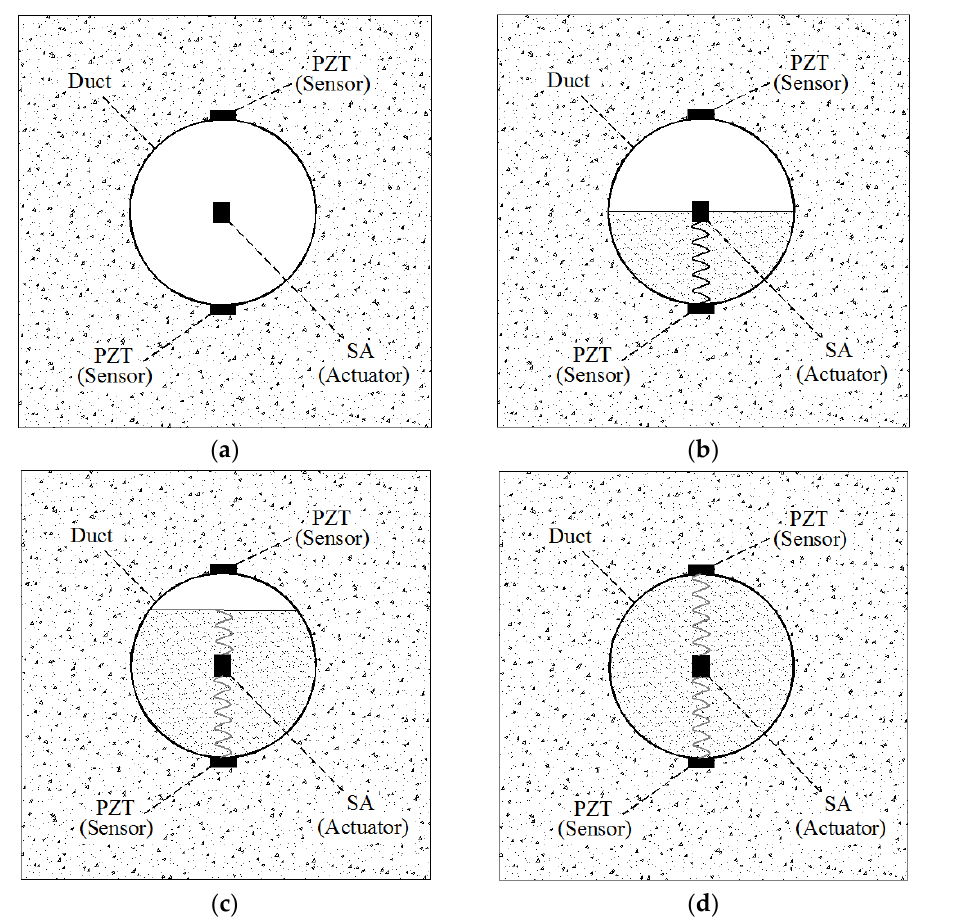
Figure 11. Principle of active sensing approach in monitoring grouting compactness: ( a ) empty duct; ( b ) half grouting; ( c ) 90% grouting; ( d ) full grouting [129].